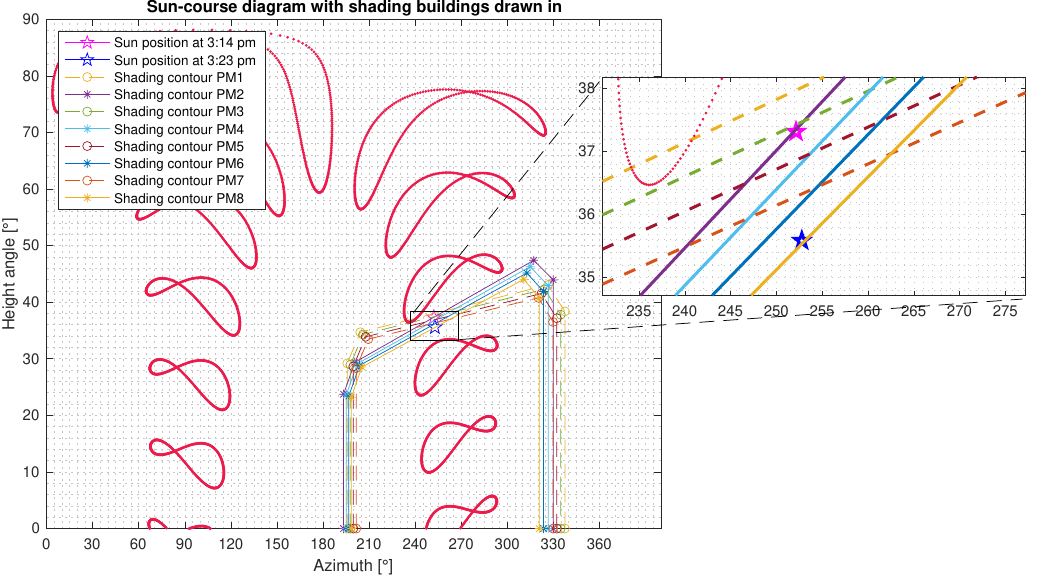
Figure 17. Solar paths with nearby objects for the experimental validation. The point in Experiment 1 (3:14 p.m. in Figure 17) is within the shading contours 1, 2, and 3 and out of the shading contours 4, 5, 6, 7, and 8, which agrees with the real operating condition shown at the left of Figure 18. This means that submodules S1 and S2 are shaded whereas submodule S3 is unshaded. Further, from the experimental measurements, it can be defined that I ph ≈ I scn = 5.486 [A] and I sc = 0.813 [A]; then, F sv = [ F S 1 F S 2 1.0 ] , where F S 1 = F S 2 = I sc / I scn = 0.813/5.486 = 0.1482. Then, using the model proposed in [32], it